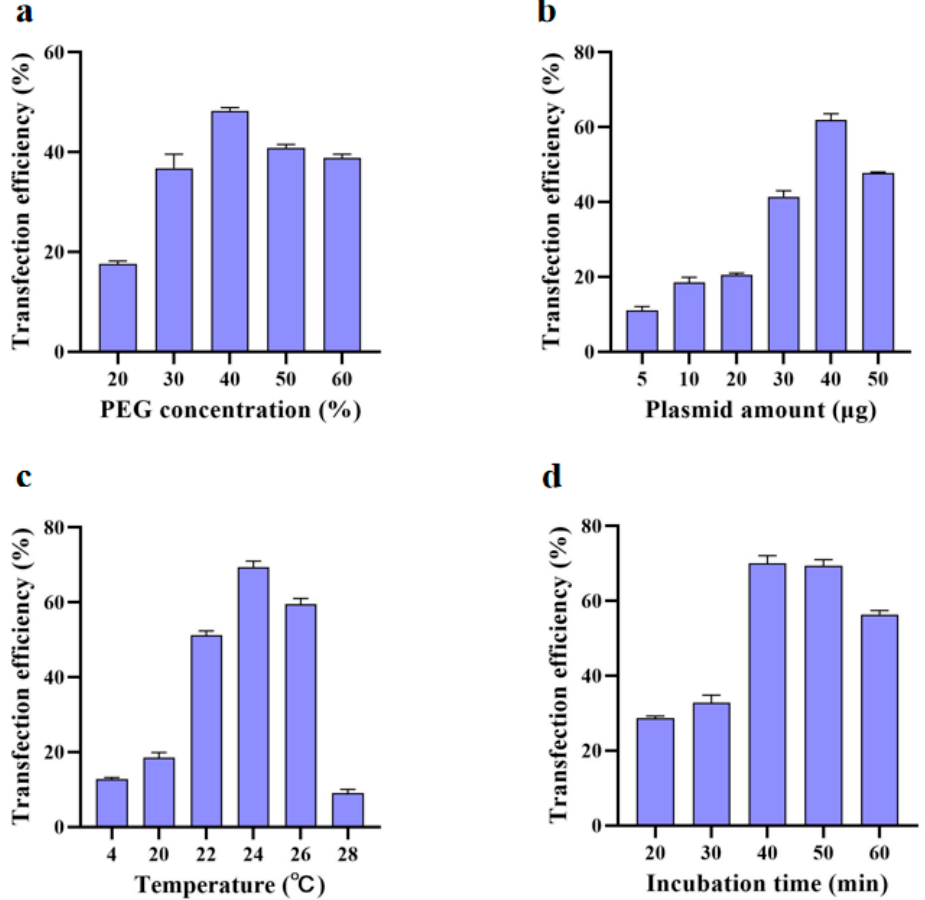
Figure 3. Transformation efficiency of U. rhynchophylla protoplasts. ( a ) Effects of PEG concentration on the efficiency of transient expression. ( b ) Effects of plasmid amount on transfection efficiency. ( c ) Effects of temperature on transformation efficiency. ( d ) Effects of incubation time on transforma- tion